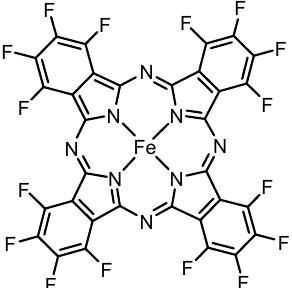
Figure 1. Structural formula of iron(II)–hexadecafluorophthalocyanine (FePcF 16 ). Molecules 2020 , 25 , 1608; doi:10.3390 /